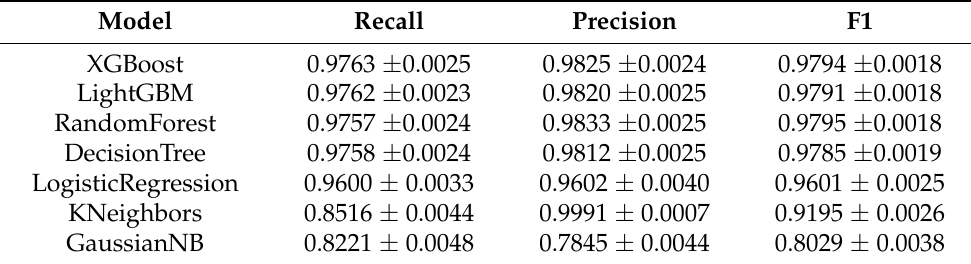
Figure 4. SHAP interaction values plot for the top two AST-JS features. ( a ) Before feature selection; ( b ) after feature selection. Table 3. Performance comparison using association rule mining AST-JS